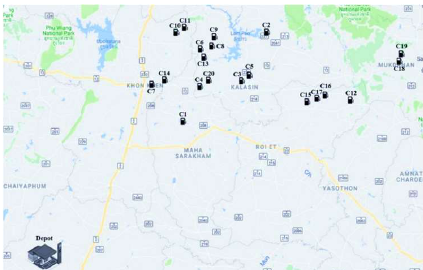
Fig. 5. The distribution network for the fuel delivery problem